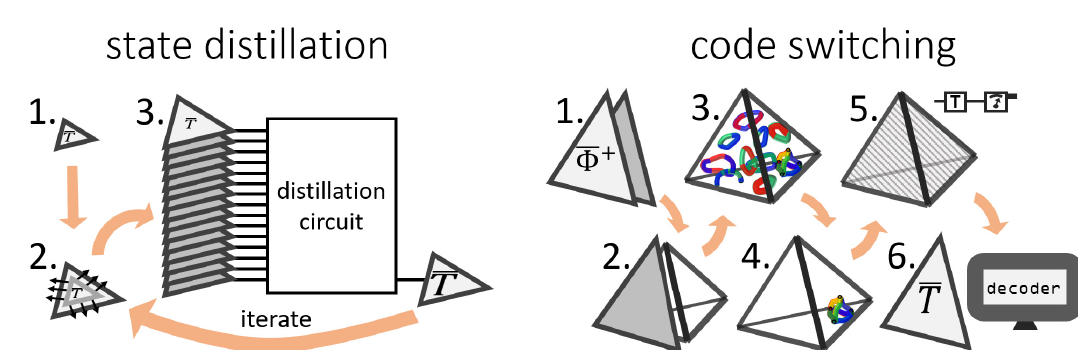
FIG. 1. Two methods of preparing high-fidelity T states encoded in the 2D color code: state distillation and code switching. Both approaches are implemented using quantum-local operations in 3D, i.e., noisy quantum operations are geometrically local, whereas ideal classical operations can be performed globally. In state distillation, many noisy encoded T states are produced and fed into a Clifford distillation circuit. In code switching, one switches to the 3D color code, where the transversal T gate is